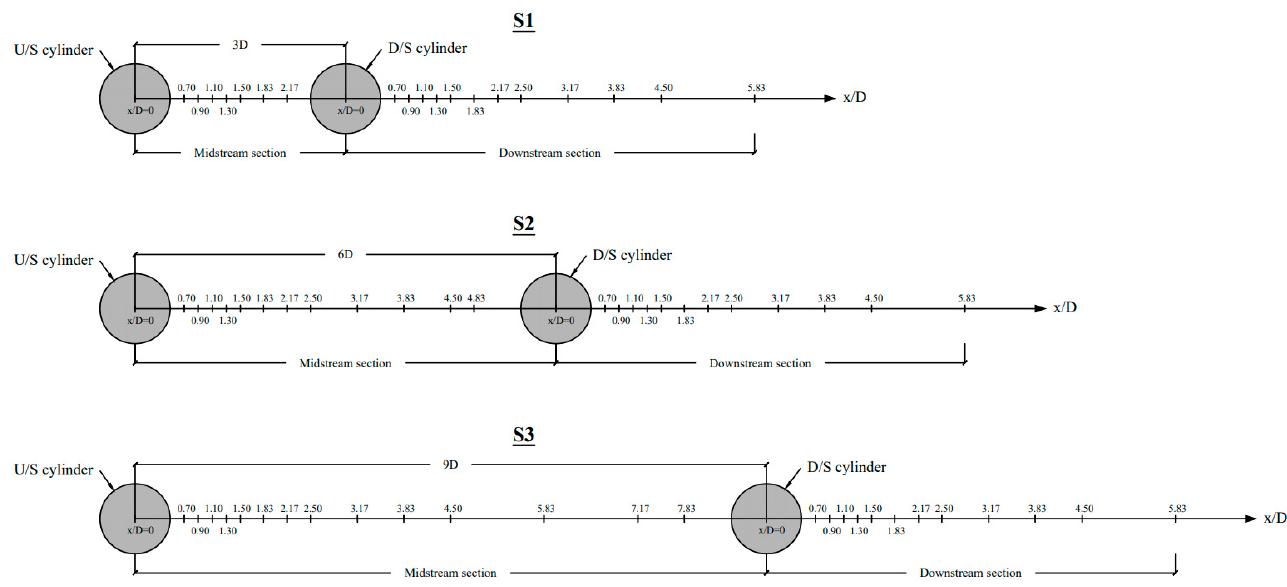
Figure 1. Plan view of the position of the measurement stations in the symmetry plane midstream and downstream for 3 scenarios: S1, S2, and S3. The + symbol shows the position of the measurement stations. U/S and D/S indicate upstream and downstream, respectively. Table 1. Details regarding the experimental scenarios.